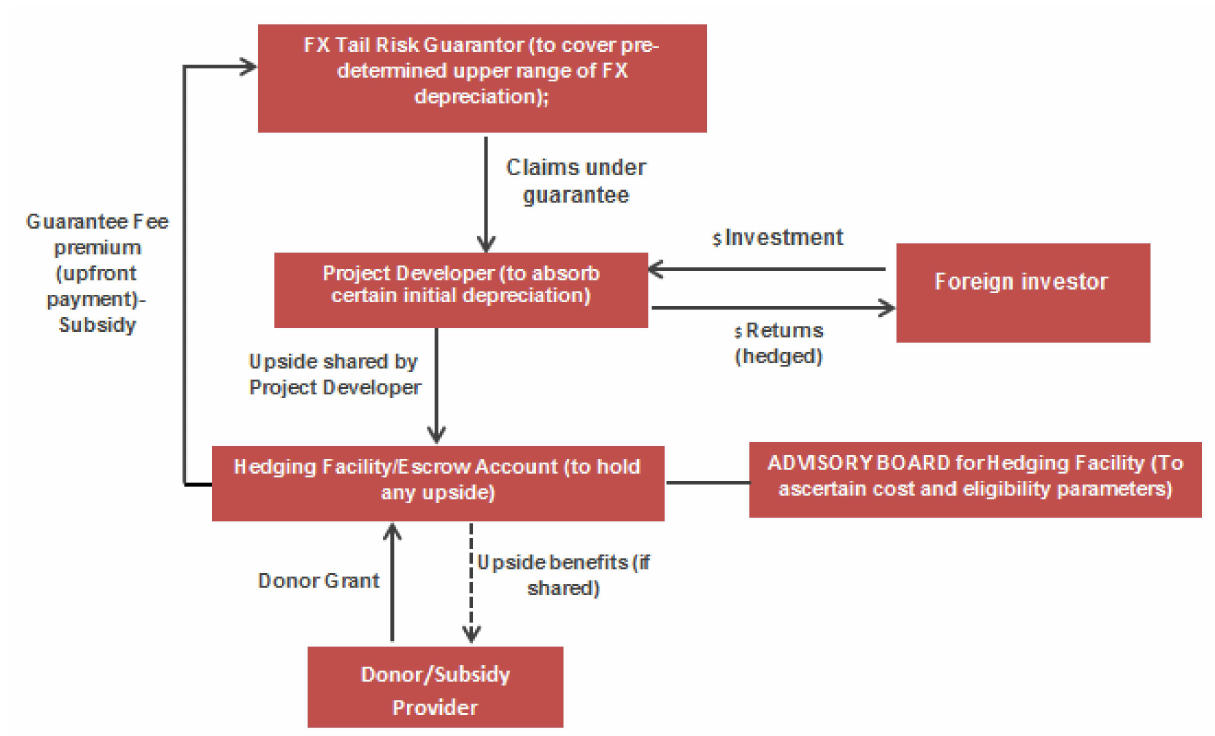
Figure 4. Transaction Structure of the FX Hedging Facility [13]. The FX hedging facility will keep (i) the donor capital to pay the FX tail risk premium upfront to the FX tail risk guarantor and will also hold (ii) the payment from the project developer (which includes the upside, if any) as the risk